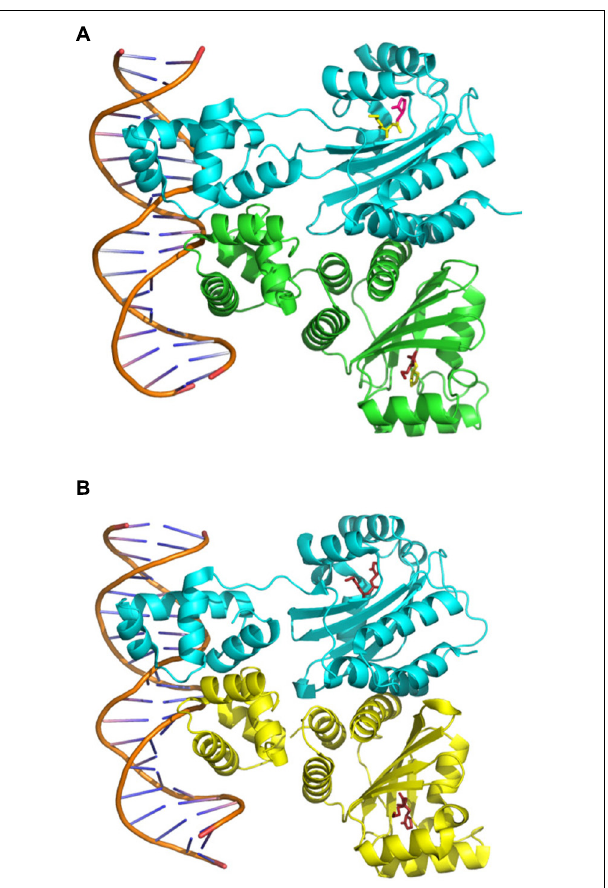
FIGURE 3 | Structures of theTraR–OC8HSL dimers in complex with DNA. The images were created using data fromThe Protein Data Bank (PDB; www.rcsb.org) (Berman etal., 2000) and the PyMOL Molecular Graphics System software. (A) PDB ID: 1H0M fromVannini etal. (2002). (B) PDB ID: 1L3L from Zhang etal.